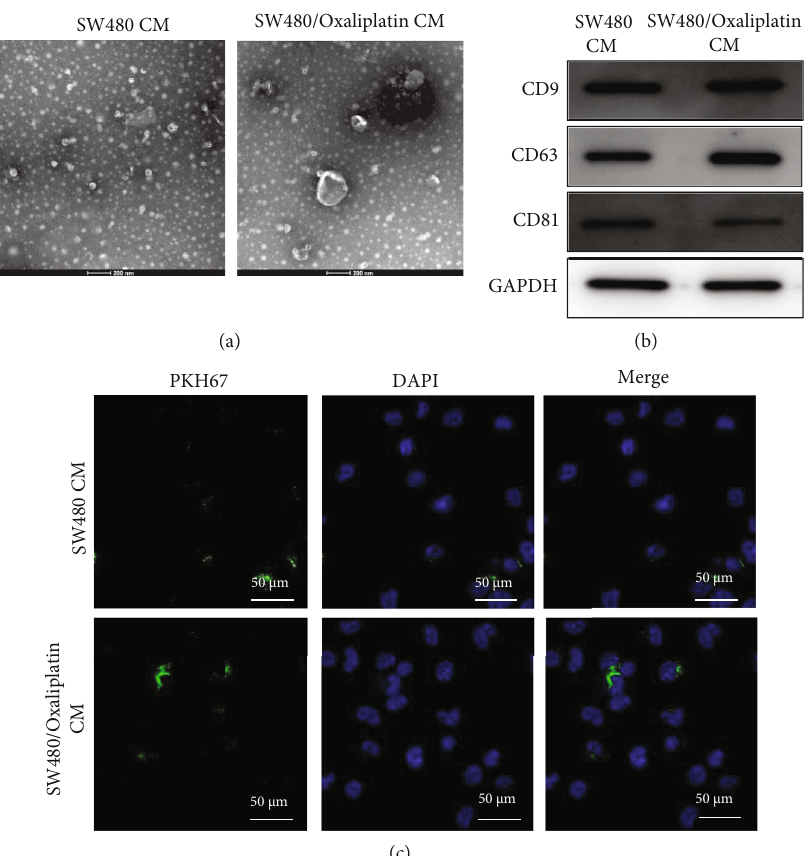
Figure 2: Characterization of exosomes of SW480/oxaliplatin cells. Exosomes were extracted from SW480/oxaliplatin and SW480 cells and then co-cultured with HUVECs. (a) Transmission electron photomicrograph of exosomes. (b) Protein expression of CD9, CD63, and CD81. (c) Confocal images of PKH67-labeled exosomes taken up by HUVECs. All the above experiments were repeatedly performed 3 times; data are shown as the means ± SD . ∗ P < 0 : 05 , ∗∗ P < 0 : 01 .